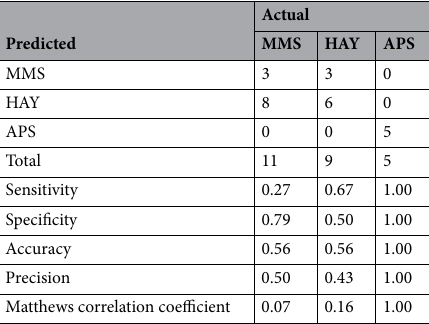
Table 4. Confusion matrix of the linear discriminant analysis (LDA) based on (+ / −) DART-HRMS metabolites; the validation was carried out on the test set ( n = 25). MMS , mix maize/crop silages; HAY , permanent meadow and lucerne hays; APS , alpine